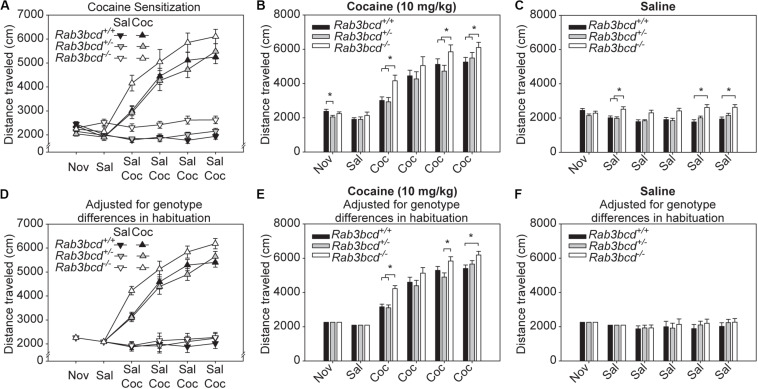
Cocaine induced locomotor activation in Rab3bcd mutants, heterozygotes, and wild types. (A) Rab3bcd–/– mutants exhibited significantly greater cocaine sensitization (p < 0.05) relative to wild types and heterozygotes on all but the second cocaine session (B). However, Rab3bcd–/– mutants also traveled a significantly greater distance relative to wild types and heterozygotes on several sessions in the saline condition beginning with the first saline injection (C), suggesting an effect of Rab3bcd on habituation to the apparatus or injection stress. After adjusting for the effect of habituation (D–F) by including distance traveled on the first two sessions as covariates, the significant effect of Rab3bcd on cocaine sensitization persisted, whereas significant differences in distance traveled between wild types, heterozygotes, and mutants in the saline condition were no longer observed. These data indicate significant effects of Rab3bcd on both habituation and cocaine sensitization. *p < 0.05.